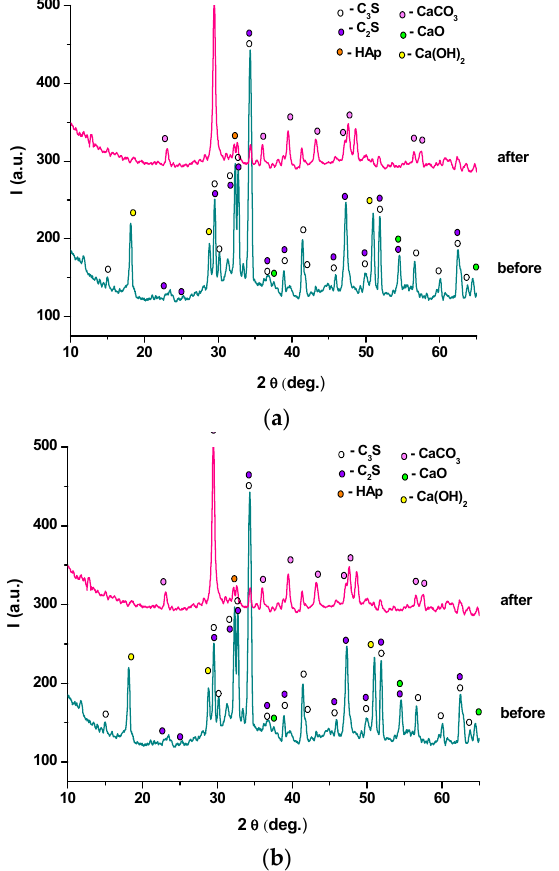
Figure 10. XRD patterns of hydrated MTA pastes before and after immersion in SBF for 14 days at 37 °C: ( a ) MTA1; ( b )